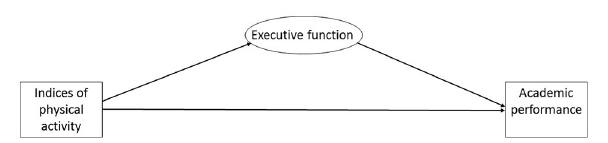
FIGURE 1 | The hypothesized